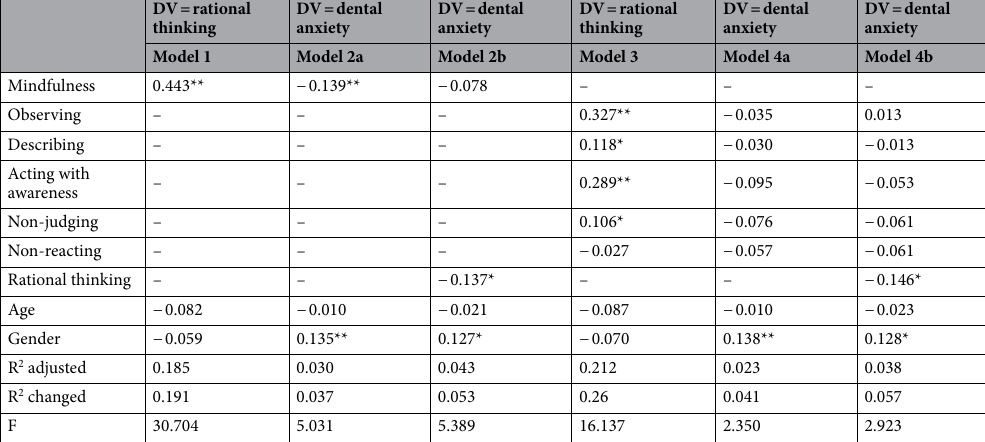
Table 4. Study 2 regression results. *p < 0.05, **p < 0.01.